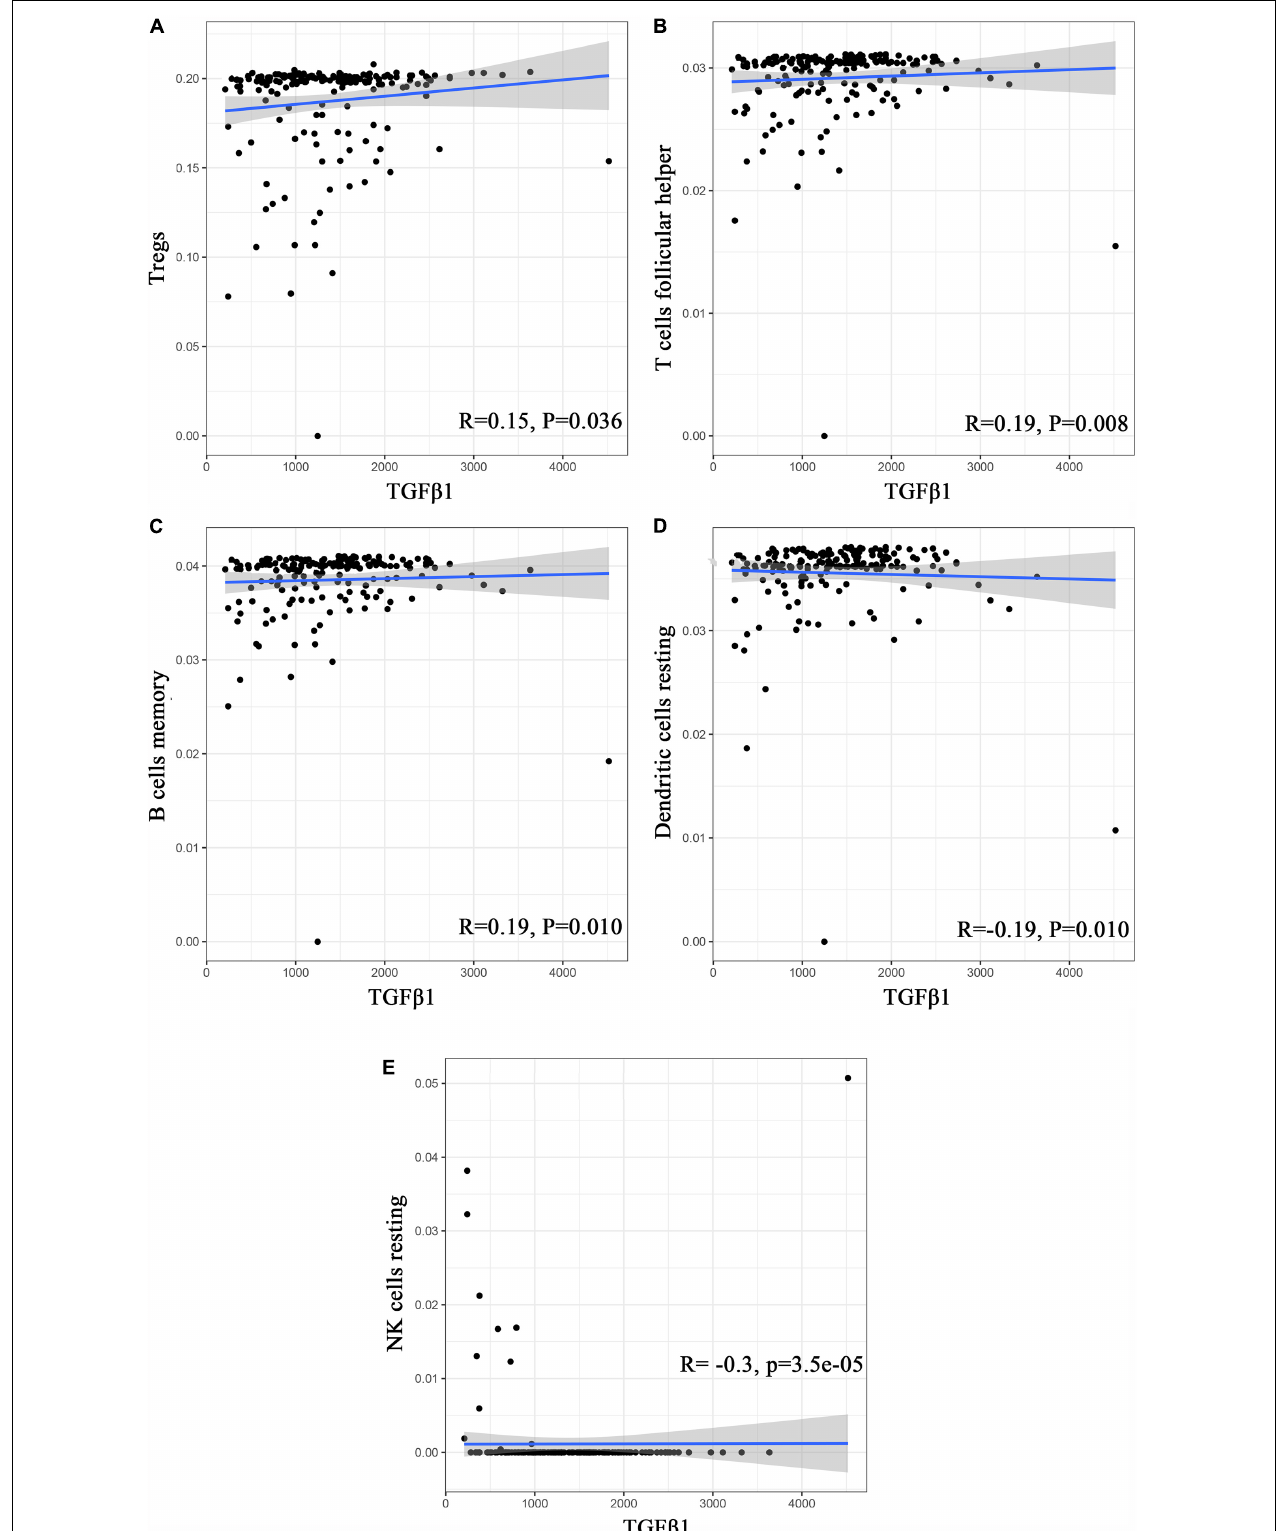
FIGURE 9 | Correlation analysis between TICs and TGF β 1 in the gene chip of GSE41258. (A–E) Scatter plot displays the association between 4 kinds of TICs and the expression of TGF β 1; Pearson coefficient was carried out for the correlation test; p < 0.05 was considered as the significance threshold and plotted.